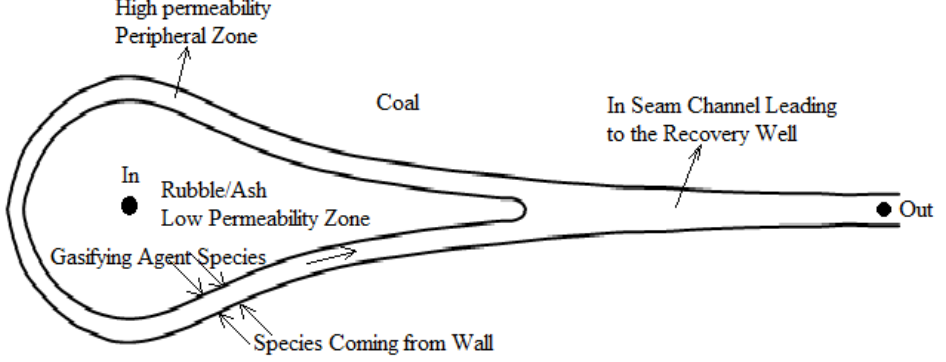
Figure 30. Conceptual sketch of the two separate zones and species flow direction (redrawn from Pirlot et al. [59]).